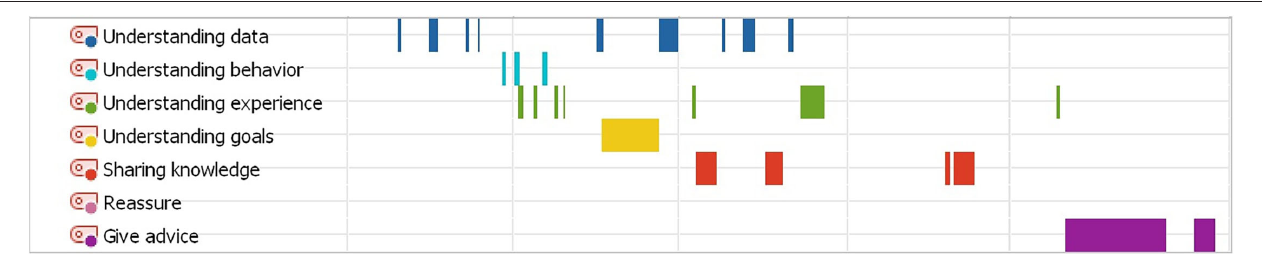
FIGURE 3 | Typical blueprint of a coaching session, illustrating the incremental pattern from data oriented to client oriented, from understanding to giving advice. All codes referring to coaching activities are highlighted; x-axis represents time in the session (A coaching session with Coach L and Clients X and Z, both data and clients present).